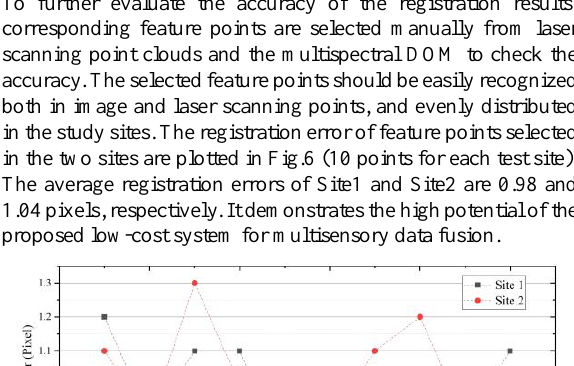
classification by illuminated—Shaded area separation. Remote Sensing 2, 19-35.